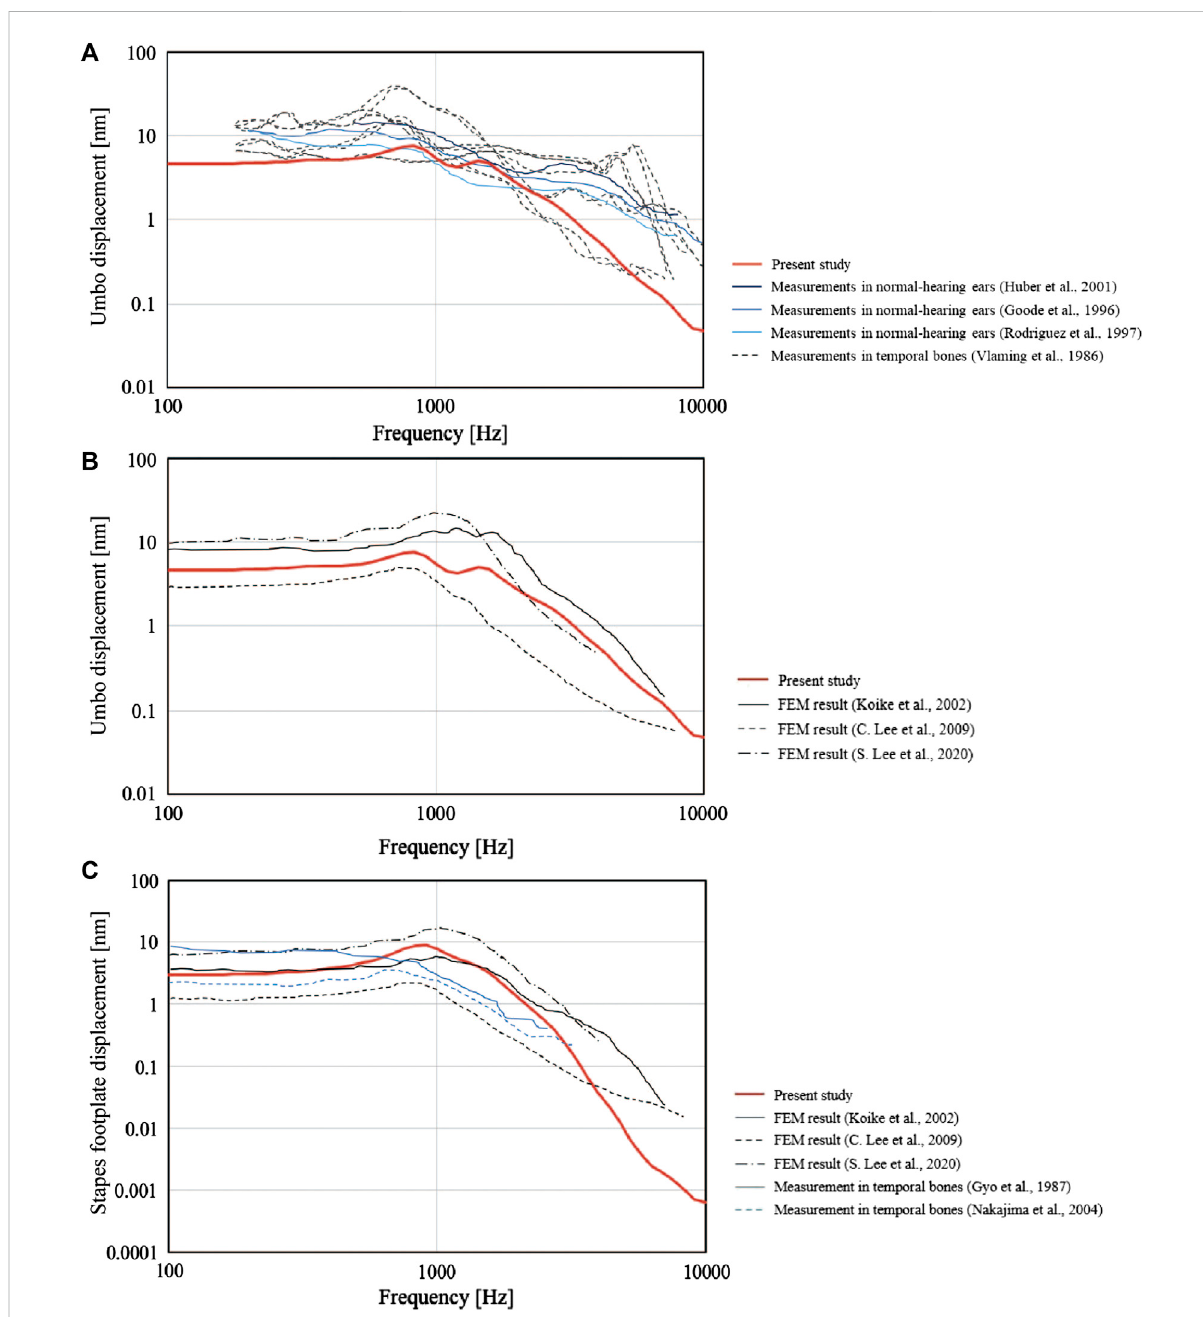
FIGURE 3 Comparisons between the present fi nite element model (FEM) and previously published data. The frequency-response characteristics of the tympanic membrane (umbo) and the stapes bone under 80 dB SPL sound pressure are shown. The values obtained by the FEM in the present study (solidredline)weresimilartothosereportedpreviously. (A) Measuredvaluesfortheperpendiculardisplacementofthetympanicmembrane(umbo). (B) Simulatedvaluesfortheperpendiculardisplacementofthetympanicmembrane(umbo)calculatedusingFEMs. (C) Measuredandsimulated (FEM) values for the perpendicular displacement of the stapes